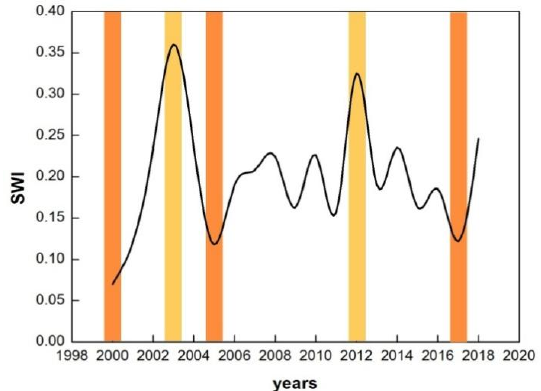
Figure 11. The temporal trends of SWI in Mu Us Sandy Land from 2000 to 2018. 2000, 2005 and 2017 (orange histogram) are defined as relatively arid years; 2003 and 2012 are defined as relatively humid years (yellow histogram).